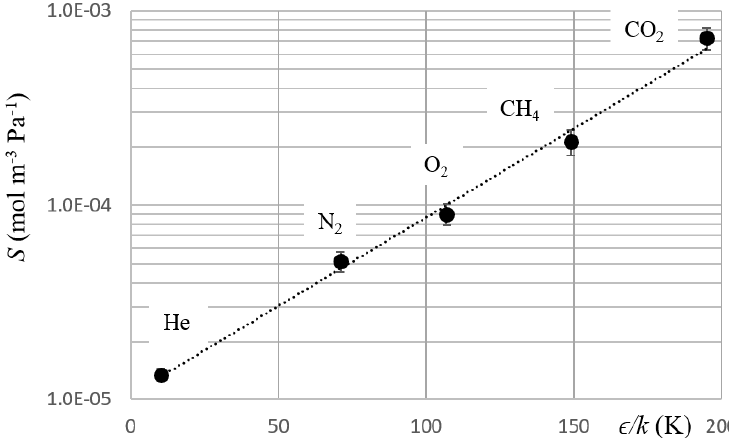
Figure 4. Solubility vs ϵ /k . The graph reports solubility as a function of Lennard–Jones temperatures.